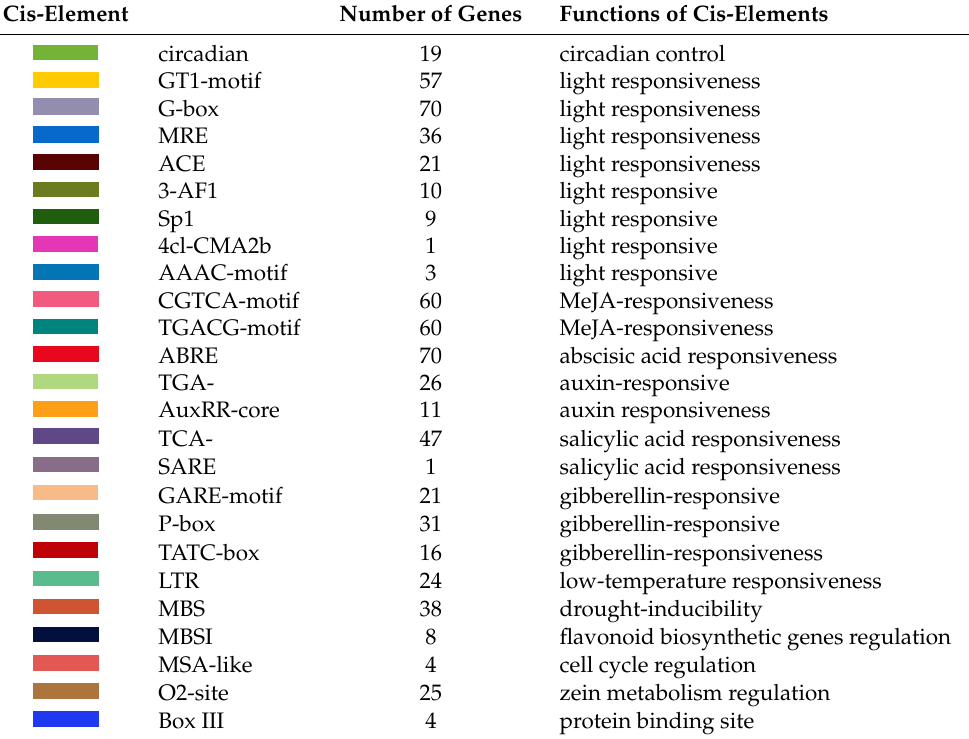
Table 5. Functionally annotated cis-elements identified in the promoters of 92 SlPP2Cs. Cis-Element